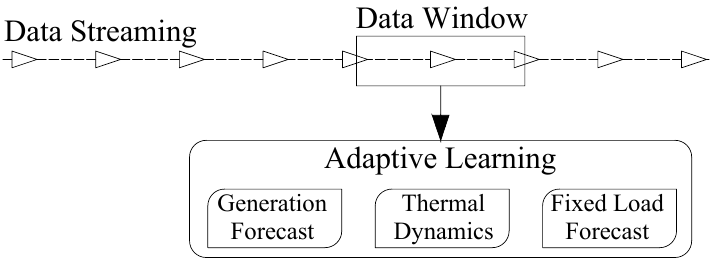
Figure 1. Adaptive learning